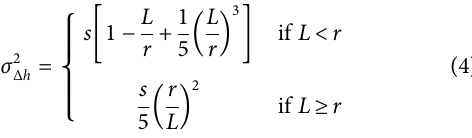
Supplementary Figure S5 ), due to systematic sub-pixel